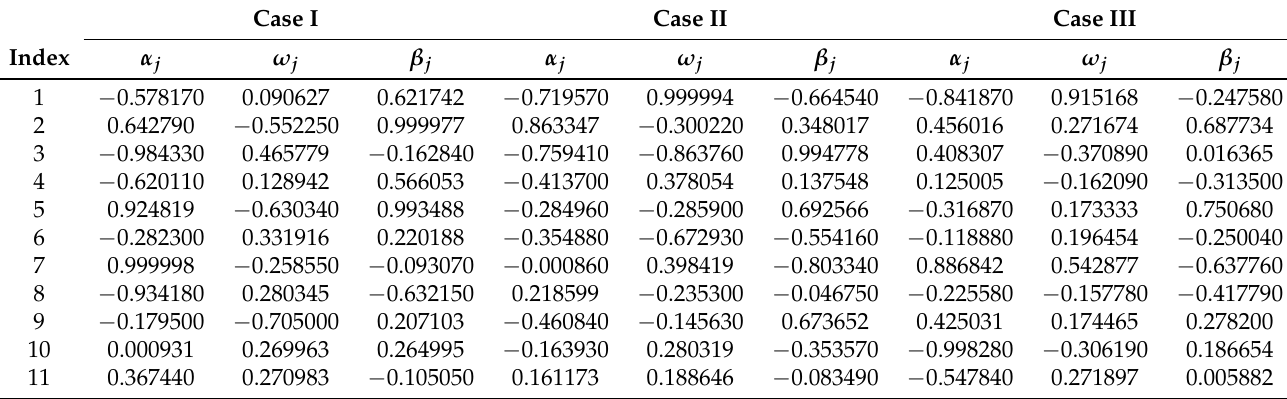
Table 9. Best set of weights obtained by the LNN-GNDO-SQP algorithm using a fitness function as in Equation (54). Here three cases are studied by varying φ in the drainage problem.